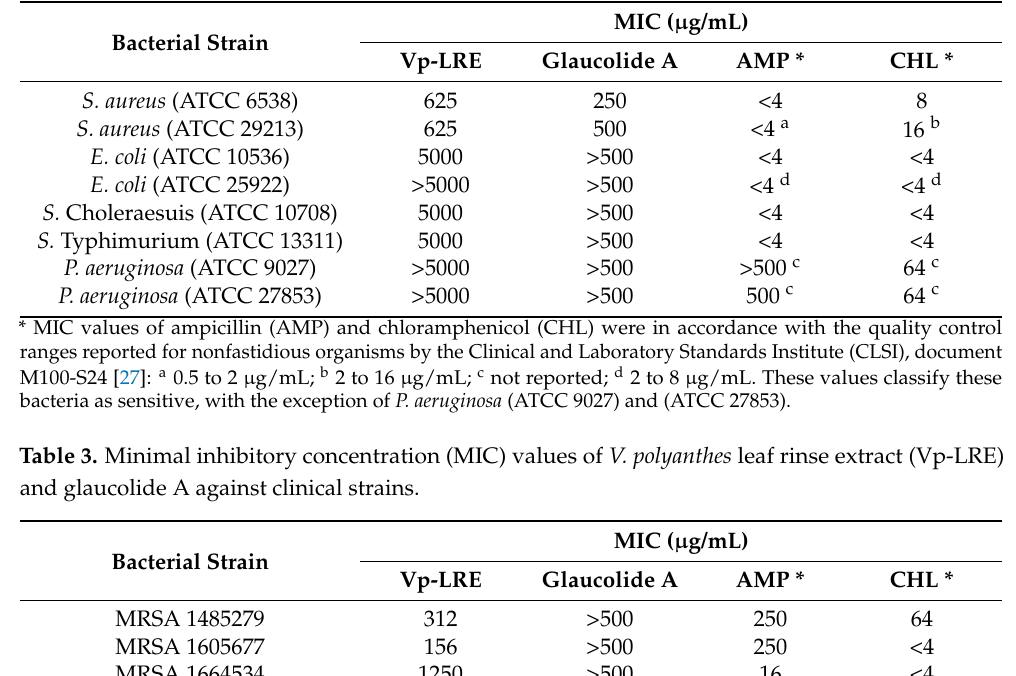
Table 2. Minimal inhibitory concentration (MIC) values of V. polyanthes leaf rinse extract (Vp-LRE) and glaucolide A against ATCC ® strains.